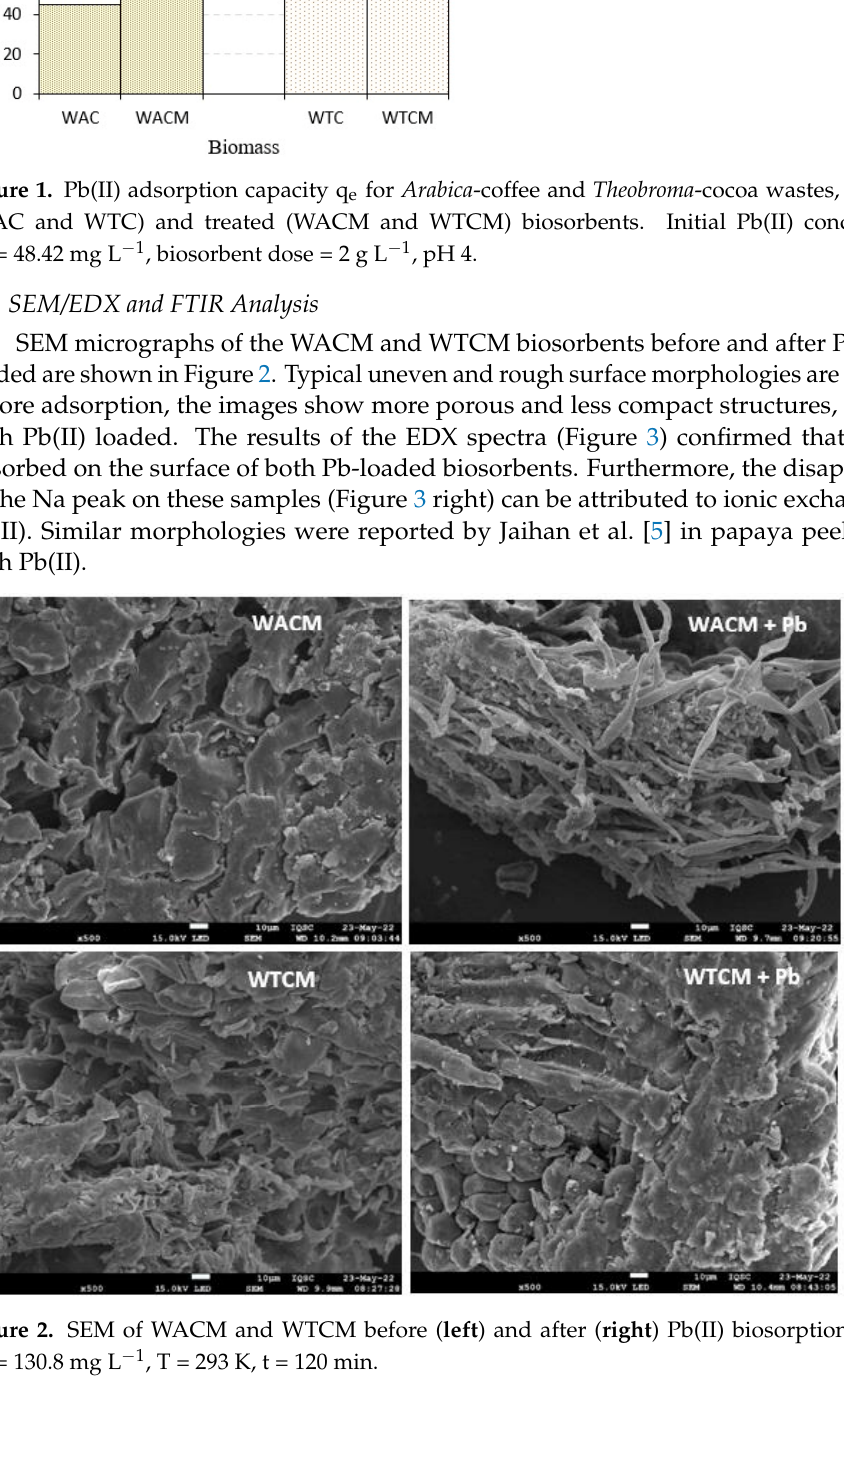
Figure 3. EDX spectra of WACM and WTCM before (left) and after Pb adsorption (right). pH = 4, C 0 = 130.8 mg L −1 , T = 293 K, t = 120 min.